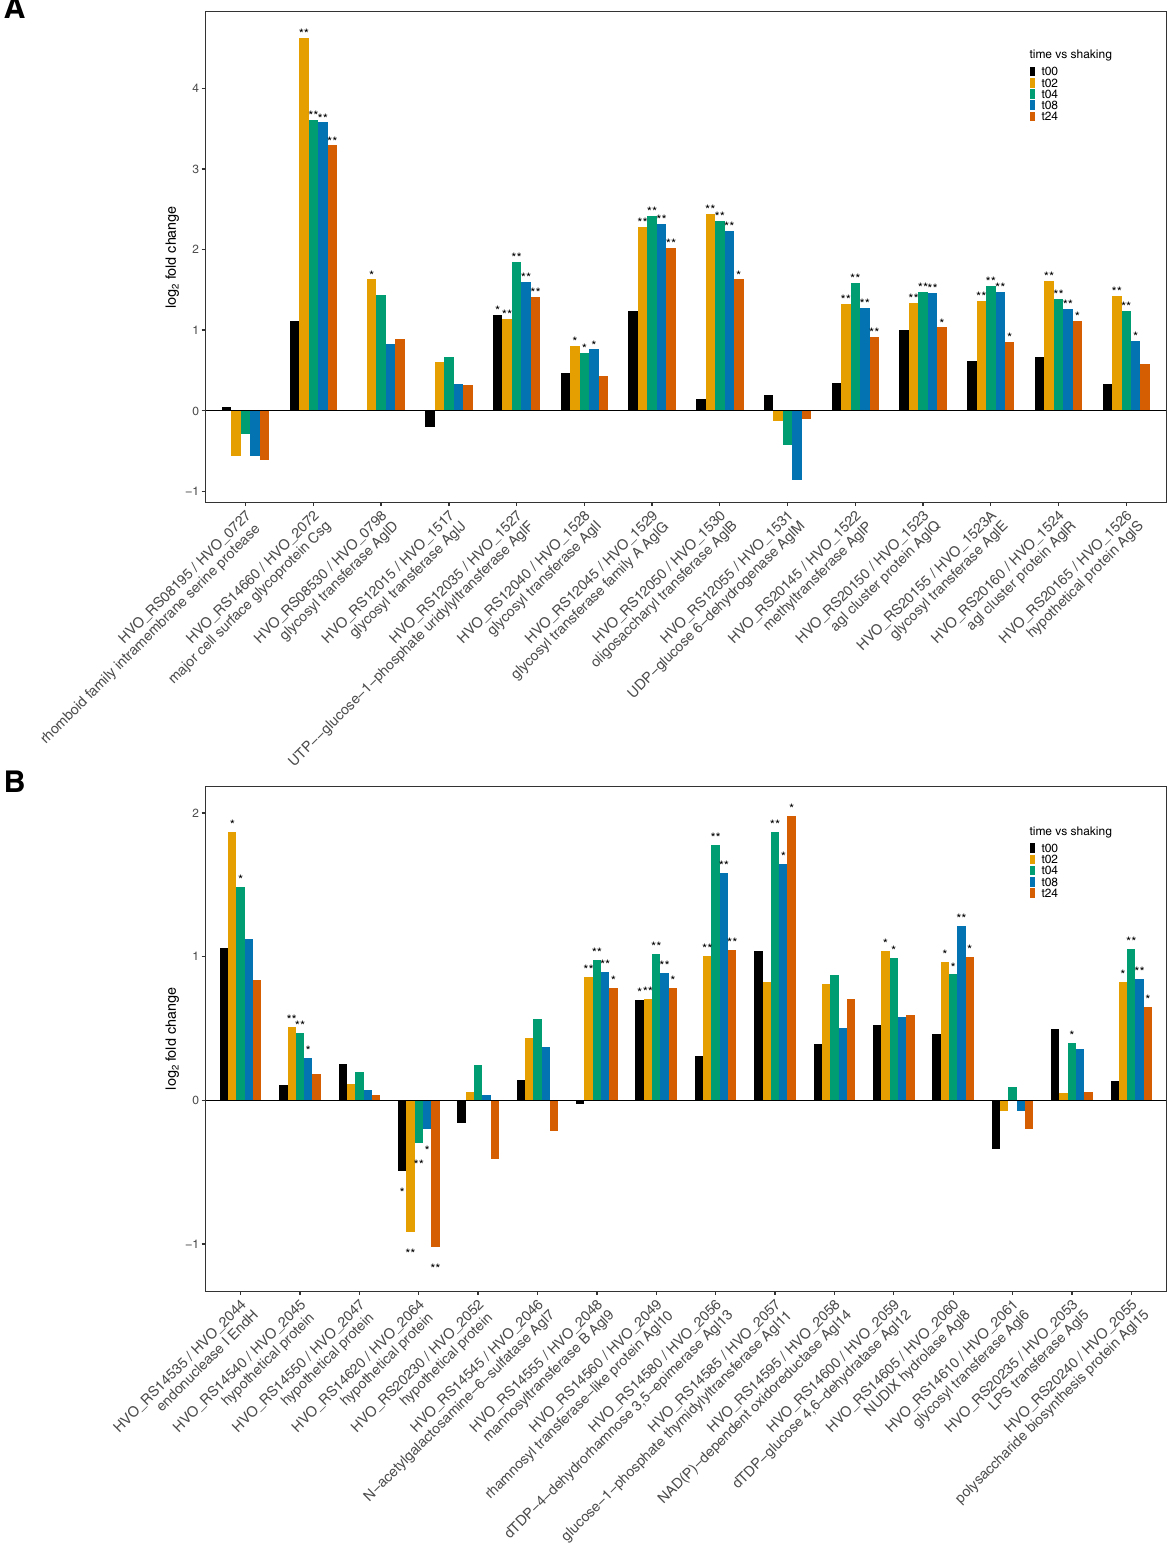
Figure 2. Bar plot depiction of differential expression compared to planktonic state for ( A ) glycosylation genes and ( B ) low-salt glycosylation genes; gene id on the x-axis and log 2 fold change on the y-axis, * p value < 0.05 and ** p value < 0.01. Genes directly involved in the N-glycosylation pathways are designated with their “ agl ” gene name and the remaining genes have a putative connection to